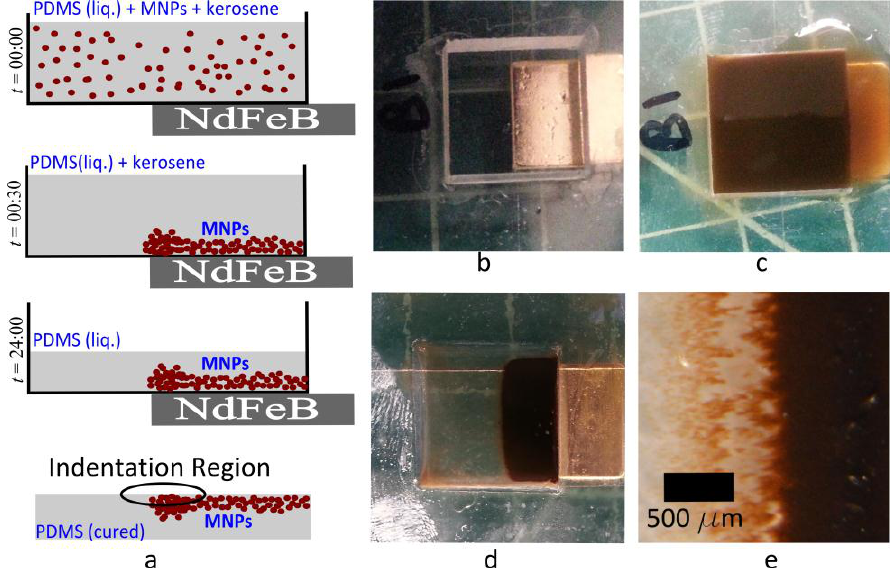
Figure 1. Control of magnetite nanoparticle (MNP) concentration distribution to pattern stiffness of polydimethysiloxane (PDMS). ( a ) PDMS is dissolved in a kerosene-based ferrofluid containing MNPs (shown disproportionately large). The solution is cast into a mold adjacent to a permanent magnet. Within ~30 min, all MNPs move to the region adjacent to the magnet. The kerosene is then evaporated and the polymer cured, thus preserving the MNP concentration distribution. Instrumented nanoindentation is performed in the region with the highest gradient of MNP concentration; ( b ) Acrylic mold with a coverslip as its floor, showing an NdFeB magnet covering part of the floor; ( c ) Solution of PDMS in kerosene is injected into the mold; ( d ) After ~30 min, MNPs concentrate in the region above the magnet; ( e ) Magnified image of the boundary, showing a sharp gradient in MNP